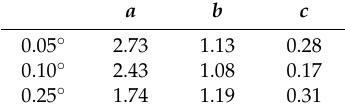
Figure 10. Simulated error variances changing with the precipitation and the gauge network density at the three grid resolutions of ( a ) 0.05°, ( b ) 0.10° and ( c ) 0.25°.